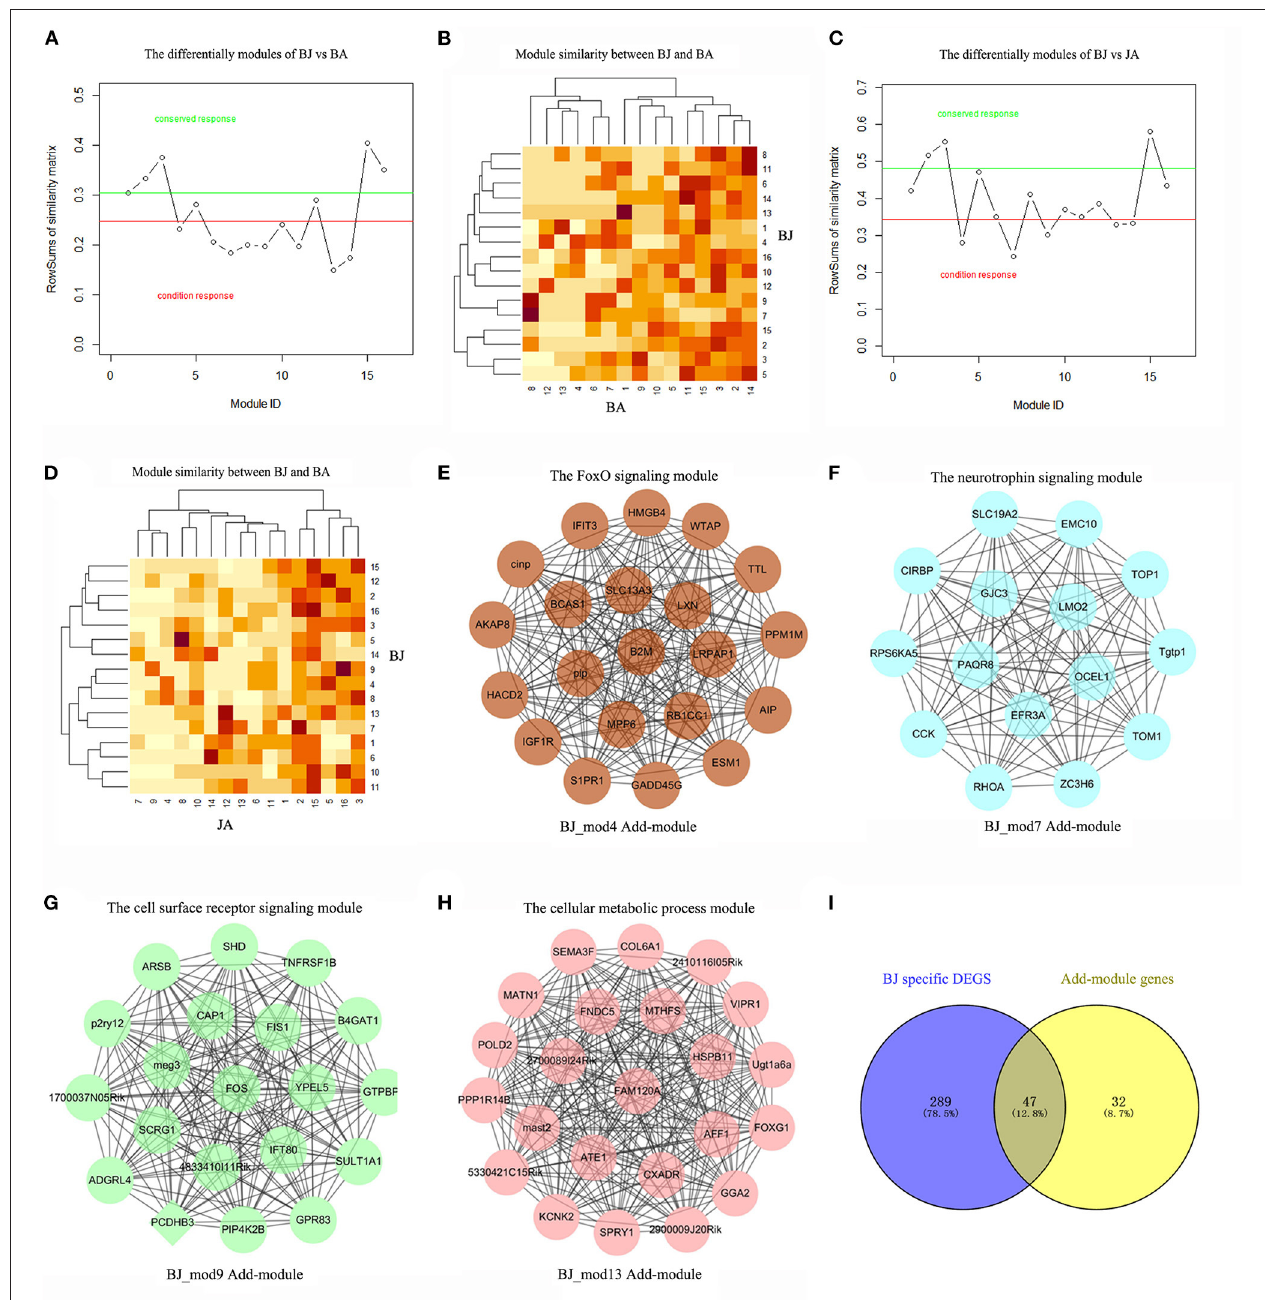
FIGURE 3 | The Add-modules of BJ compared with BA and JA. (A) The BJ specific On-modules compared with BA, modules under the red line were BJ’s specific modules. (B) The heatmap of module similarities between BJ and BA. (C) The BJ specific On-modules compared with JA. (D) The heatmap of module similarities between BJ and JA. (E–H) The visualization of BJ Add-modules, which are the specific On-modules compared with both Vehicle group, BA and JA. Each module was named by the ID and its enriched functions. (I) The genes’ overlapping between BJ Add-modules and BJ specific